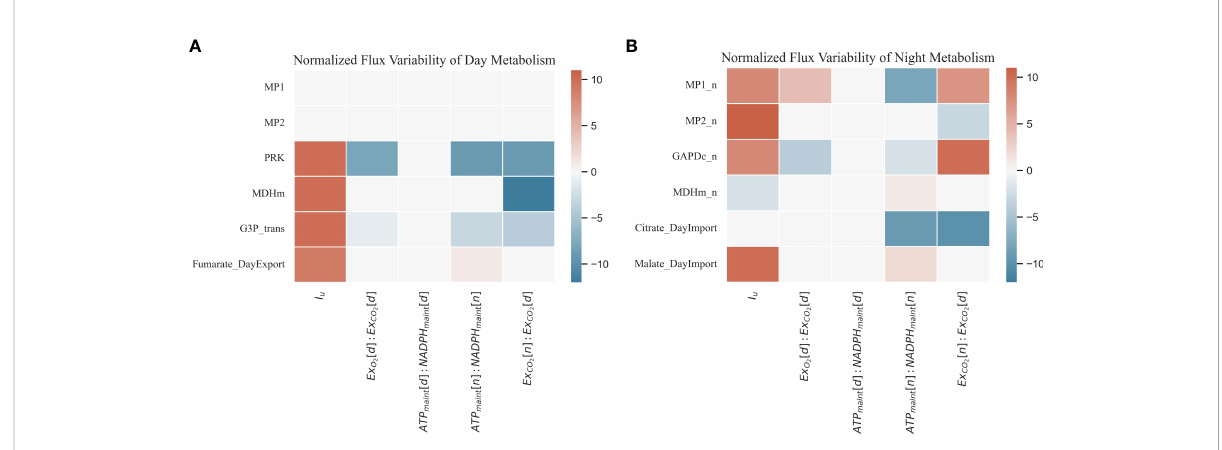
FIGURE 7 Normalized sensitivity analysis result of a selection of day (A) and night (B) metabolic fl uxes (B) according to a given range of ratios and constraints